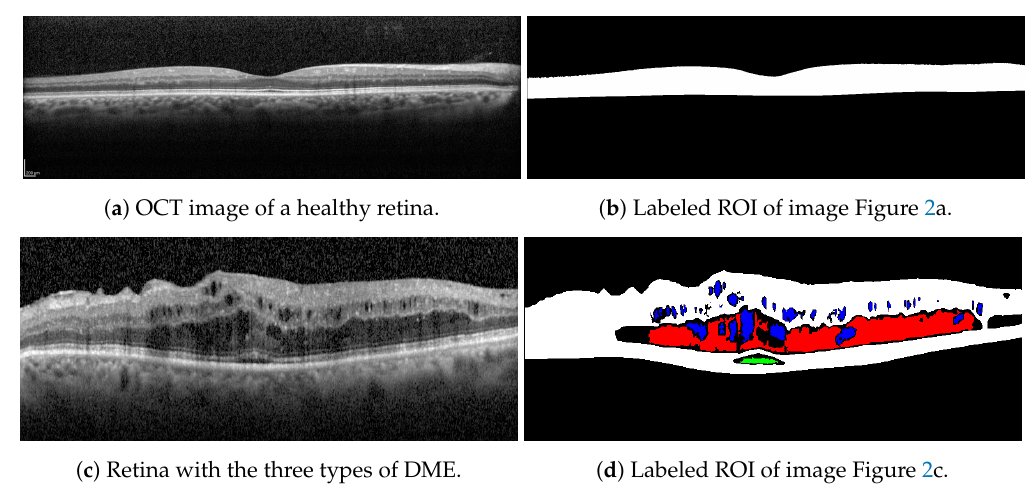
( c ) Retina with the three types of DME. ( d ) Labeled ROI of image Figure 2c. Figure 2. Labeled mask examples of OCT images. In blue: CME, in red: DRT and, in green: SRD.